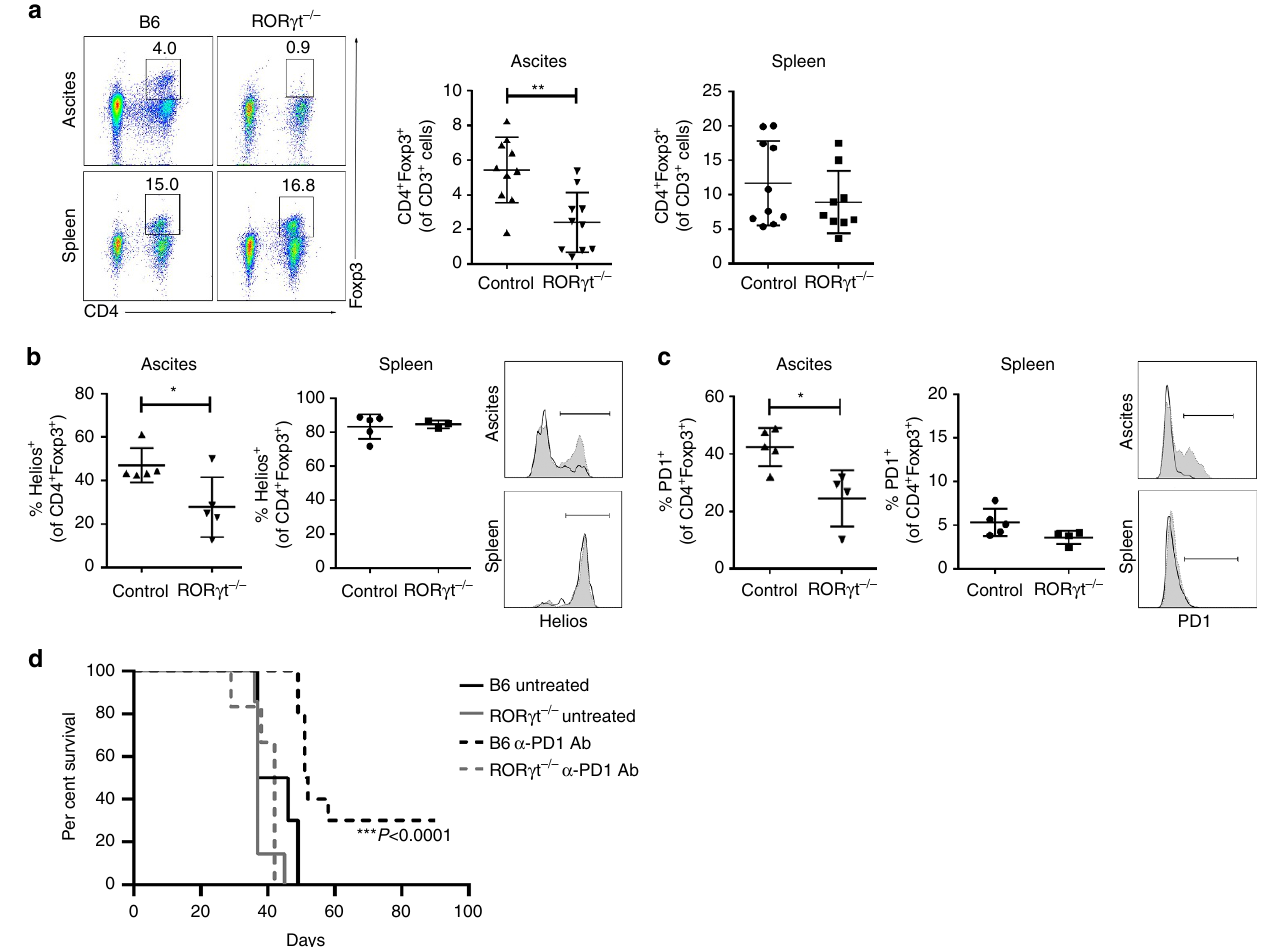
Figure 2 | Changes in tumour-associated T reg cells in Ror c t (cid:2) / (cid:2) mice. Ror g t (cid:2) / (cid:2) and B6 mice were injected i.p. with ID8A cells. ( a ) The percentage of Foxp3 þ CD4 þ cells of CD3 þ cells in the tumour ascites and spleens were determined on day 35 ± 2. Representative staining (left) and statistical analysis (right) of pooled data from two independent experiments with n ¼ 5 mice, respectively. The fluorescence-activated cell sorting (FACS) gating strategy of live Tcells is presented in Supplementary Fig. 8b. ( b , c ) Percentages of Helios þ ( b , left) and PD1 þ ( c , right) and representative staining of Foxp3 þ CD4 þ cells in tumour ascites and spleens from n ¼ 5 mice. Black line indicates the staining of CD4 þ Foxp3 þ cells from B6 mice and grey filled line CD4 þ Foxp3 þ cells from Ror g t (cid:2) / (cid:2) mice. ( d ) Survival time was monitored in untreated and a -PD1 antibody (Ab)-treated Ror g t (cid:2) / (cid:2) ( n ¼ 5) and B6 mice ( n ¼ 10). Mice were treated with either PBS (200 m l i.p.) or RMP1–14 ( a -PD1 Ab, 5mgkg (cid:2) 1 , BioXcell, 200 m l i.p.) on days 3, 6, 9 and 12. Spleens and ascites from untreated B6 and Ror g (cid:2) / (cid:2) mice ( n ¼ 5 per group) were collected at day 35 ± 2 and cells purified. Survival curves were compared using